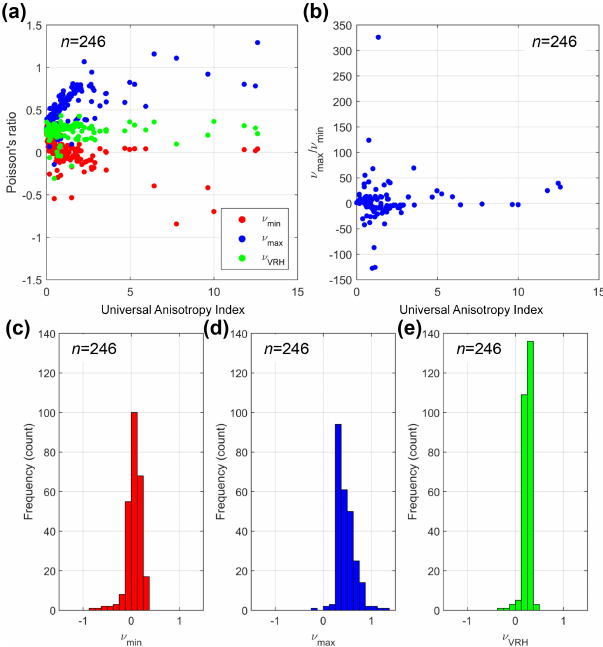
Figure 12. (a) Anisotropy of Poisson’s ratio in rock-forming minerals ( n = 246) plotted against the Universal Anisotropy In- dex of Ranganathan and Ostoja-Starzewski (2008). ν VRH is the Voigt–Reuss–Hill average of ν . (b) Plot of ν max /ν min versus A U . (c) Histogram of ν min values shown in Fig. 12. Note that 28% ( n = 70 / 246) of minerals display negative ν min . (d) Histogram of ν max values. Note 37% ( n = 91 / 246) minerals display ν max > 0 . 5. (e) Histogram of ν VRH values. Mean ν VRH = 0 . 2464, very close to the common default assumption of ν = 0 . 25.